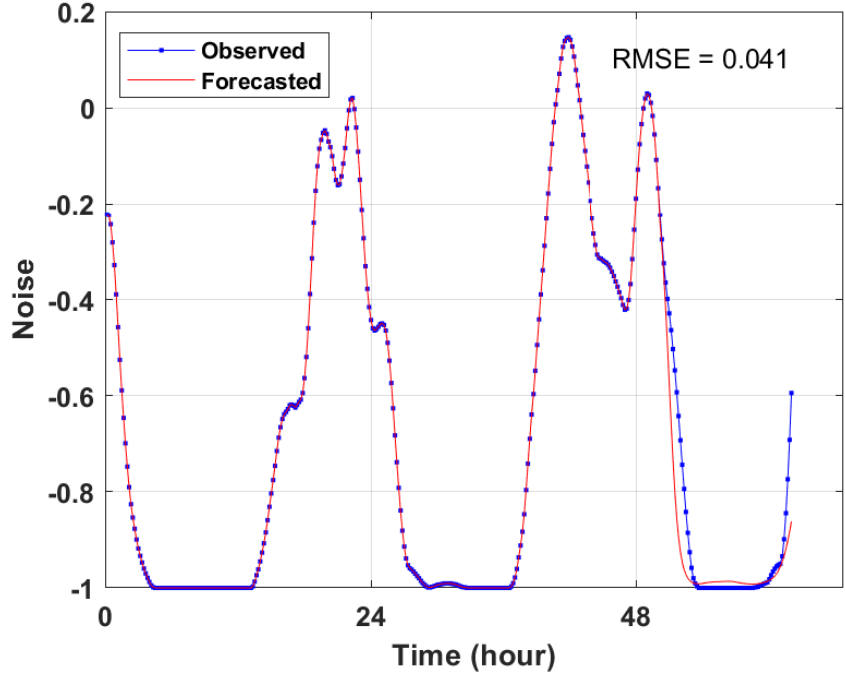
Figure 12. Noise forecasting by